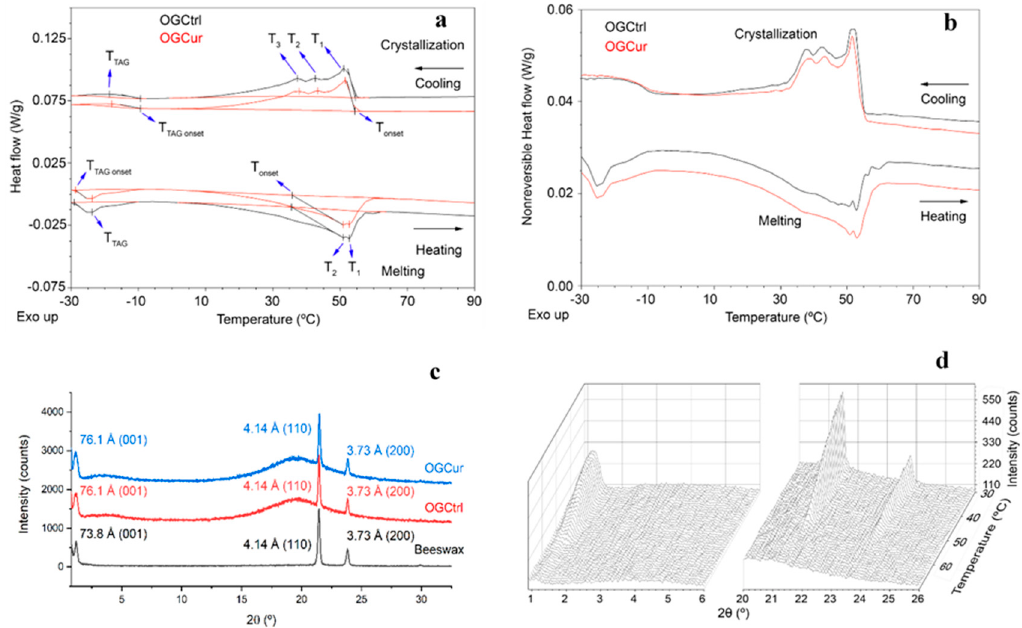
Figure 3. ( a ) MDSC thermograms (total heat flow) for OGCur and OGCtrl. ( b ) MDSC thermograms (non-reversible heat flow) for OGCur and OGCtrl. ( c ) XRD patterns at 30 °C for beeswax (black line), OGCur (blue line) and OGCtrl (red line). ( d ) XRD pattern as a function of temperature during cooling for OGCur.